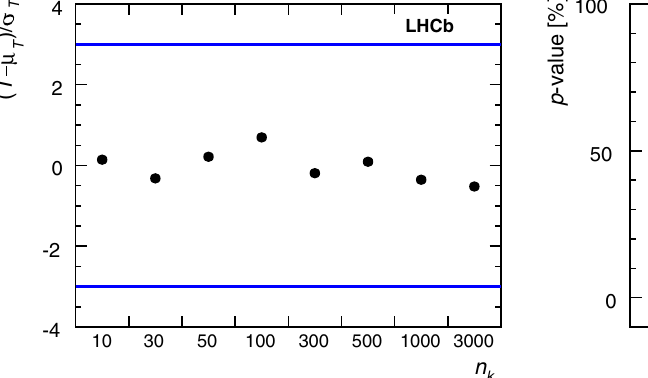
The horizontal lines in the left figures represent − 3 and + 3 pull